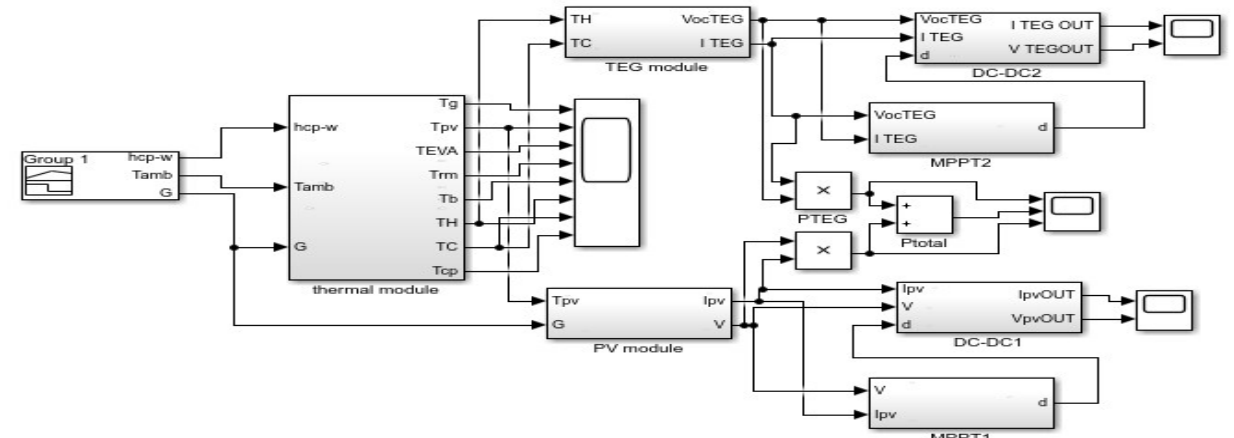
Figure 5. Block diagram PVTEG.